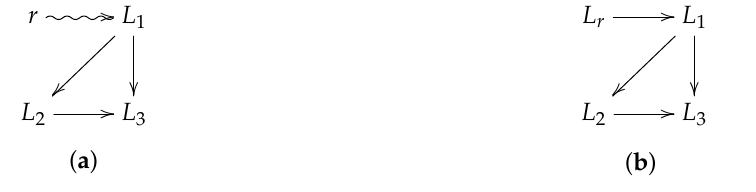
Figure 3. LSRMs network with the virtual LSRM modeling reference. ( a ) with reference; and ( b ) with virtual